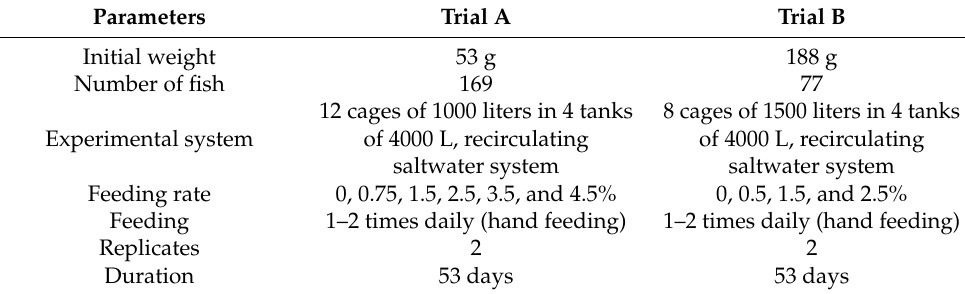
Table 1. Experimental